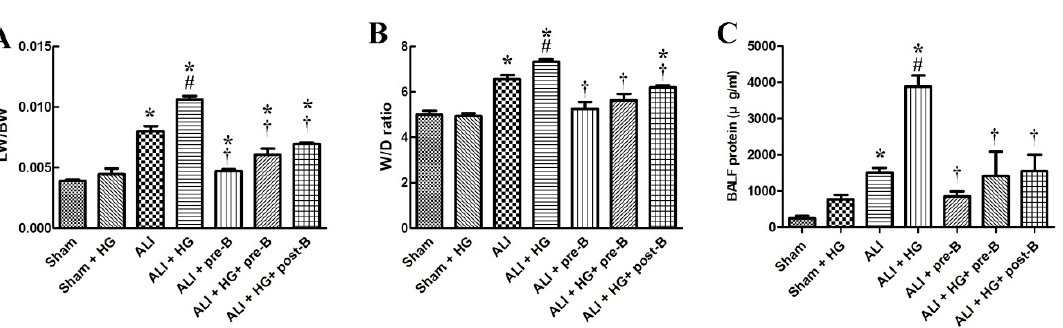
Figure 2. E ff ects of hyperglycemia and NKCC1 inhibitor treatment on pulmonary edema and alveolar protein leakage. The LW / BW ( A ) and W / D ratios ( B ) were significantly increased in rats with ALI and further increased in rats with ALI + HG ( p < 0.05). The NKCC1 inhibitor reduced pulmonary edema in both ALI and ALI + HG groups ( p < 0.05). The TP concentration in BALF ( C ) was prominent in rats with ALI and further increased in rats with ALI + HG ( p < 0.05). The NKCC1 inhibitor reduced alveolar protein leakage in both ALI and ALI + HG rats ( p < 0.05). * Significant di ff erence, as compared to the sham group ( p < 0.05), # Significant di ff erence, comparing the groups with HG to those without HG (I vs. II, III vs. IV, V vs. VI, and V vs. VII, p < 0.05), † Significant di ff erence, comparing the ALI groups with B to those without B (III vs. V, IV vs. VI, and IV vs. VII, p < 0.05). Abbreviation: LW / BW = lung weight / body weight, W / D = lung wet / dry weight ratio. ALI = acute lung injury, HG = hyperglycemia, pre-B = pretreatment with bumetanide, post-B = post-treatment with bumetanide, BALF = bronchoalveolar lavaged fluid, TP = total